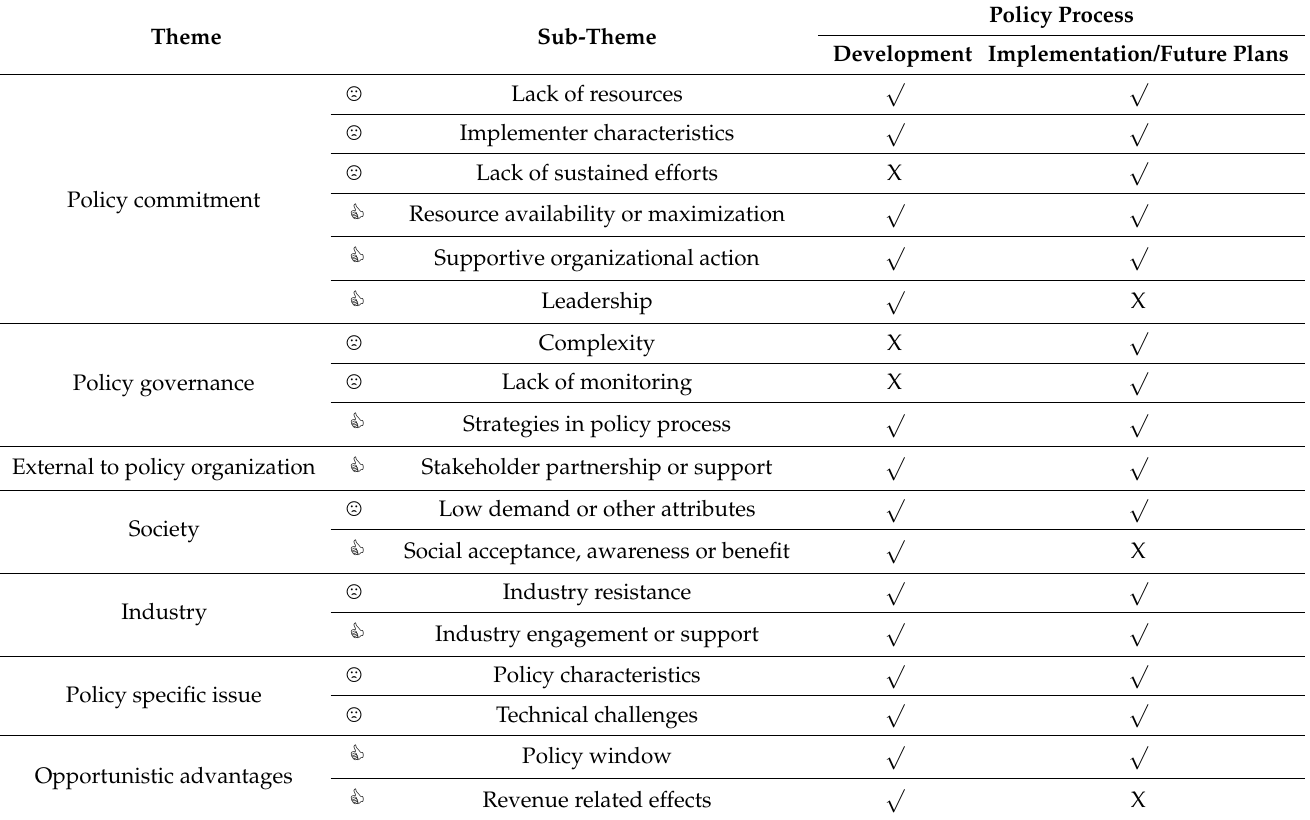
Table 1. Summary of barriers and facilitators as per stage of policy process.